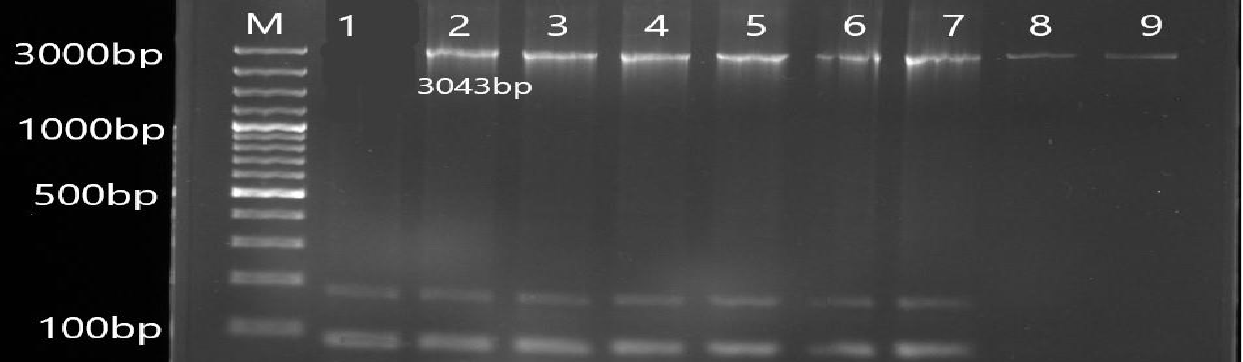
Figure 3. Electrophoresis showing amplicons of P. aeruginosa oprL gene. Lane M: 100 bp molecular marker, Lane 1: Negative control, Lane 2: Positive control, Lane 3 – 9: Positive isolates of oprL .